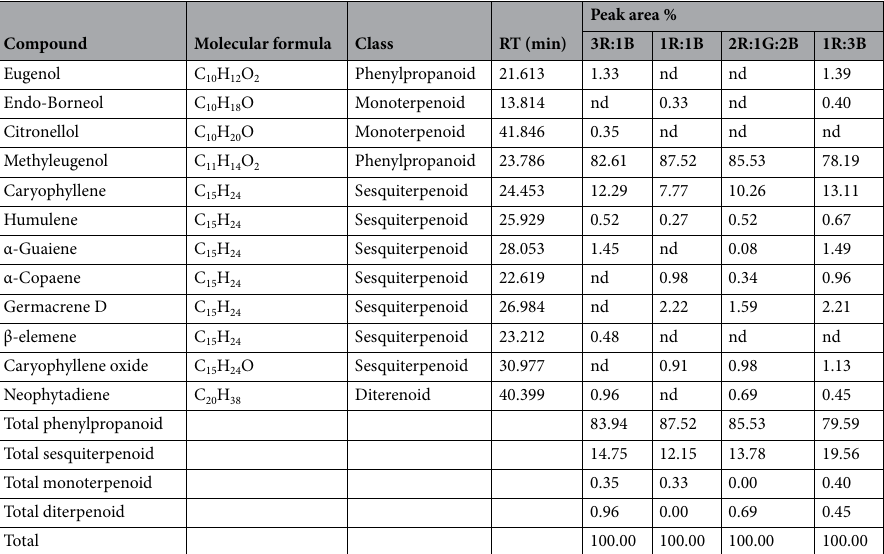
Table 2. Chemical profiling of green holy basil under different light spectrum ratios (3R:1B, 1R:1B, 2R:1G:2B, and 1R:3B) at vegetative stage. “nd” indicates not detected. R, G and B represent the red, green and blue llight spectra, respectively, and number before the letters stand for the ratio of each lighrt spectra.